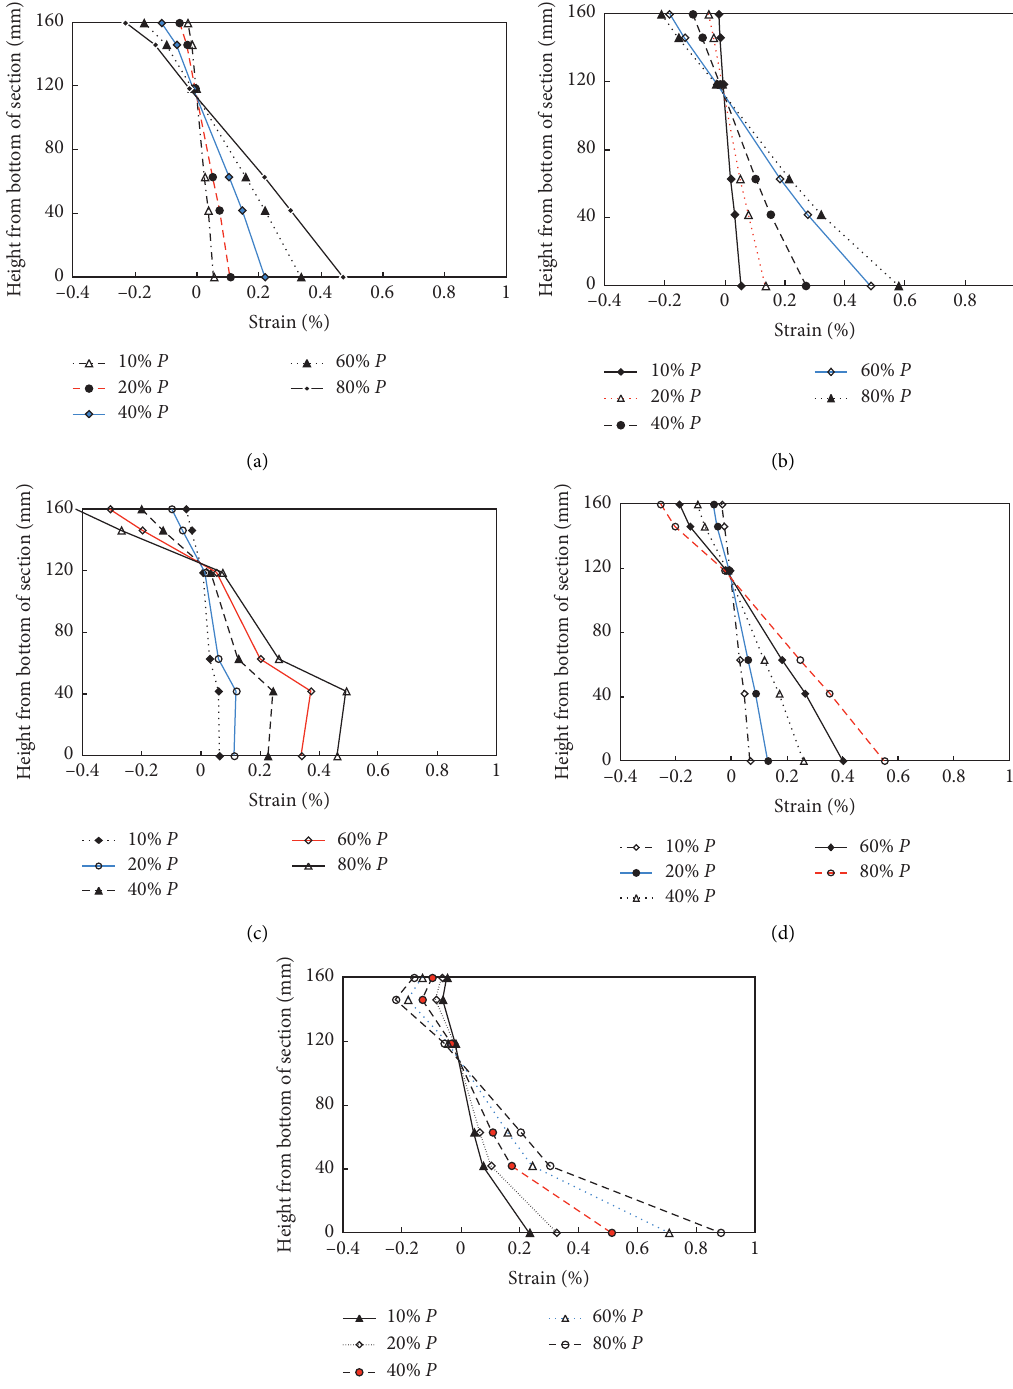
Figure 7: Typical strain distribution curves across the depth at mid-span: (a) S4D, (b) S4DH, (c) S4DV, (d) S4DT2, and (e) The experimental results indicated that local buckling tends to occur in the thin facesheets on the compressive region of sandwich decks. To investigate the influence of GFRP layers on the top of decks, three different layers (i.e., 4, 6, and 8) are tried on the top of S4D specimens,